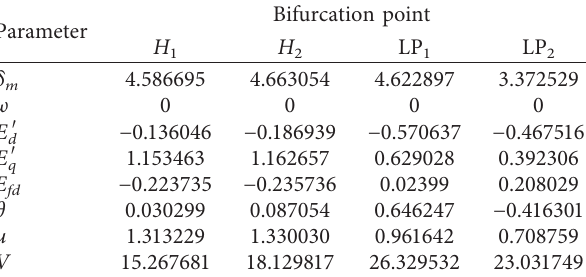
Figure 9: u − t curve.